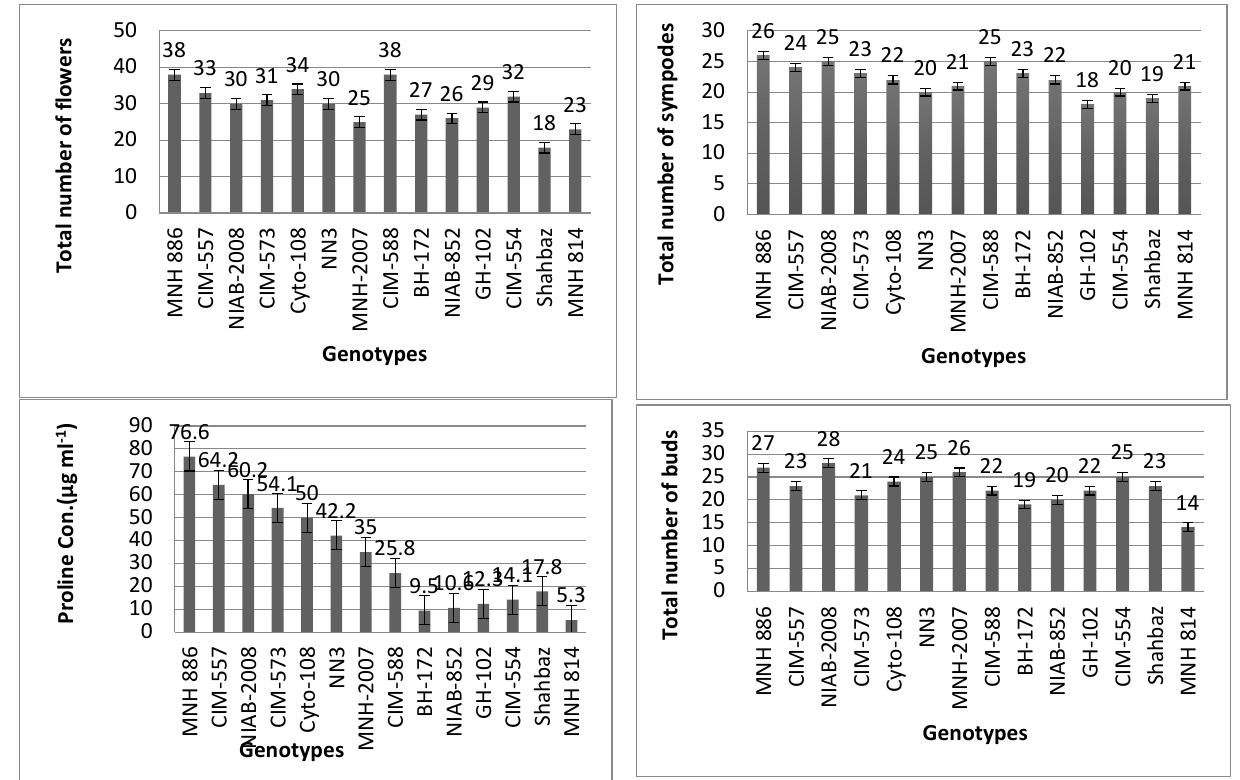
Figure 1. Mean values of phenotypic variations of morpho-physiological traits related to the heat stress of 14 cotton genotypes.